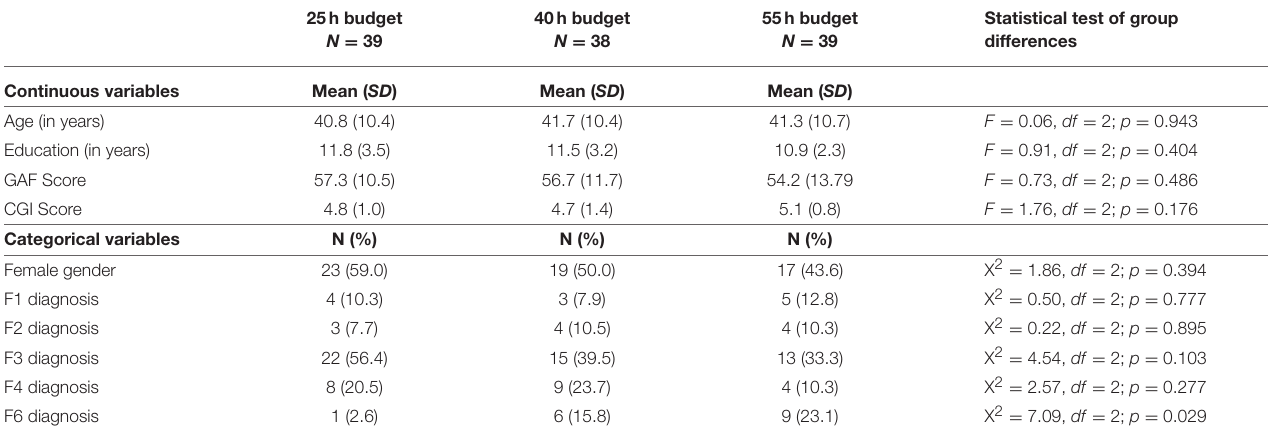
TABLE 1 | Baseline characteristics across study